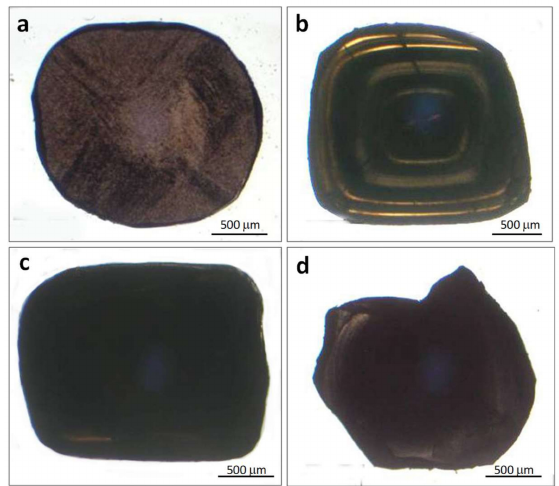
Figure 1. Polished thin sections of cuboid diamonds from placers in the northeastern Siberian craton with predominantly silicic (( a ) HI-91 and ( b ) HI-95) and predominantly carbonatitic (( c ) HI-105 and ( d ) HI-111) microinclusions. Transmitted